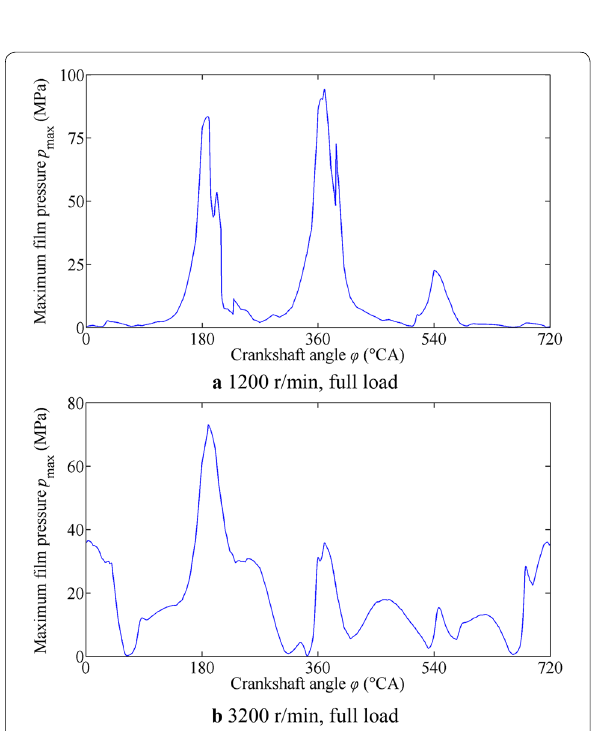
Figure 8 Maximum oil film pressure of No. 2 main